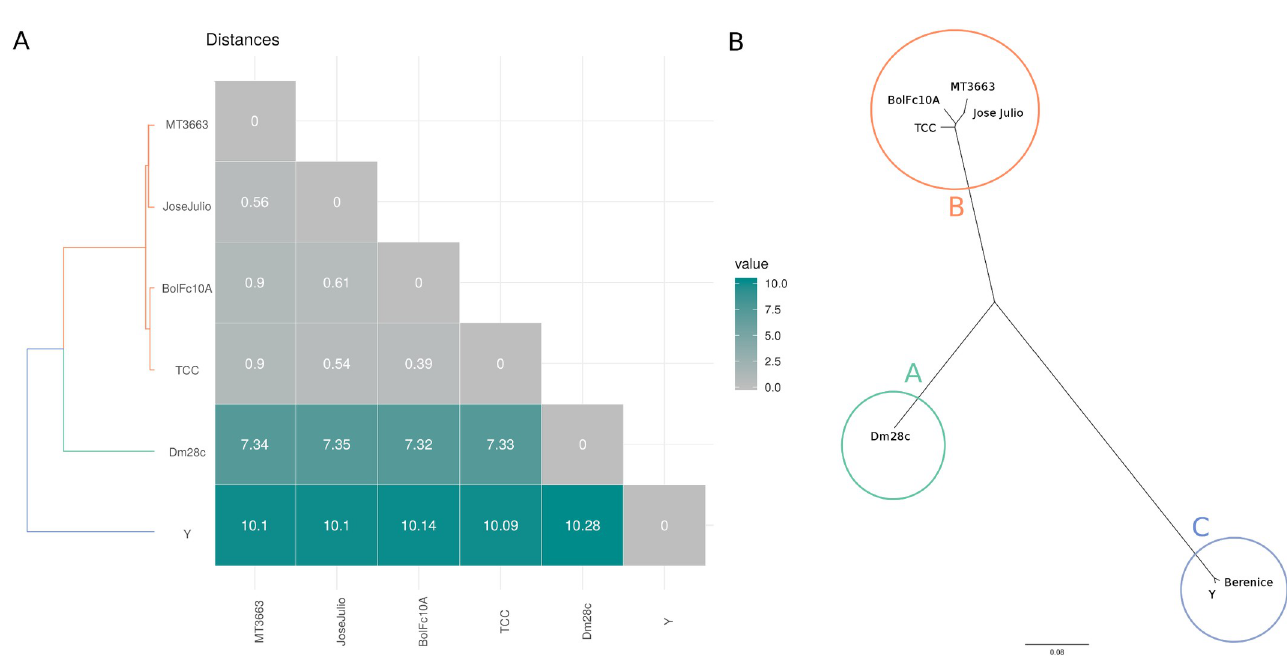
Fig 4. Maxicircle phylogeny. A. Matrix of all-against-all uncorrected p-distance. B. Phylogenetic maximum likelihood tree, unrooted visualization (Clades A, B and C are indicated by circles).